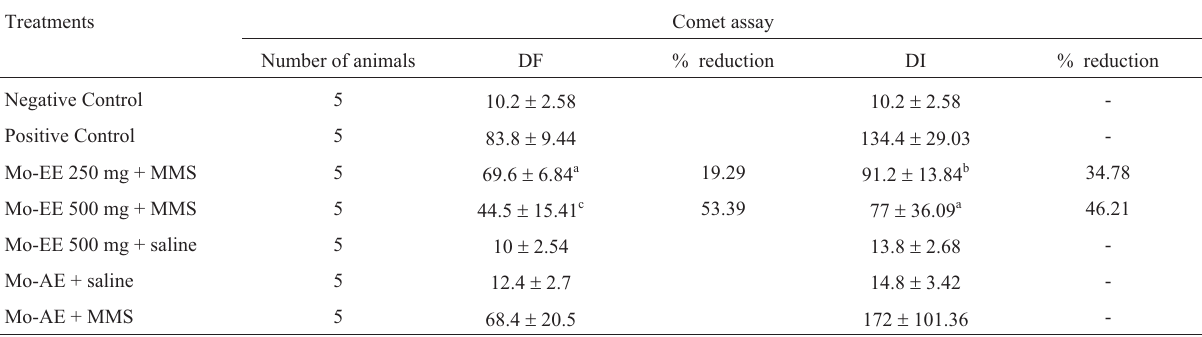
Table 2 - Detection of lesions in DNA (mean (cid:2) SD) using the comet assay (DF and DI) in peripheral blood cells of mice exposed to methyl metha- nesulfonate (MMS, 40 mg/kg) and different doses of Melissa officinalis .